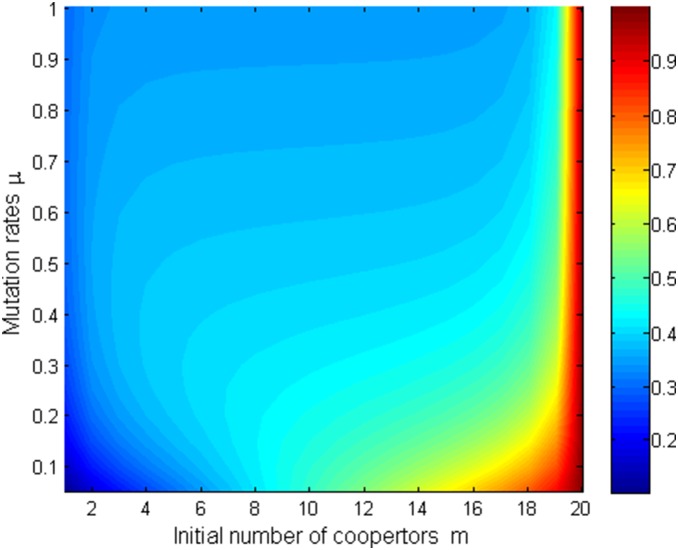
µ, m vs ρm with β = 0.01, b = 1.2.